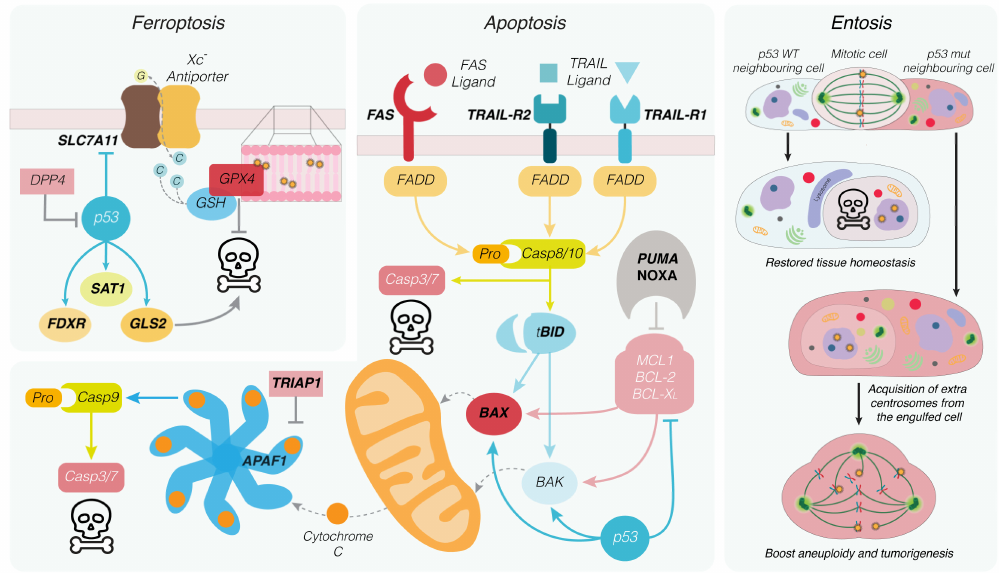
Figure 3. Critical p53-regulated cell death modalities. Upon alterations of the cellular redox state, iron-dependent peroxida- tion of membrane phospholipids can occur, promoting ferroptosis. Peroxidation can be reversed by the selenocysteine- containing protein glutathione peroxidase 4 (GPX4) in a glutathione (GSH)-dependent manner. By inhibiting the transcrip- tion of the system Xc - complex subunit SLC7A11, p53 reduces the reservoir of cysteine (C) necessary for GSH synthesis, thus preventing reversion of lipid peroxidation. Moreover, p53 controls the transcription of FDXR, SAT1 and GLS2, favouring cell death via ferroptosis. Extrinsic apoptosis is initiated by e.g. FAS or TRAIL ligand binding to their cognate receptors promoting the multimerization of receptor trimers. These form the cell death inducing signalling complex (DISC) that recruits the adapter protein FADD, which promotes activation of the initiator caspase-8, which activates in turn executioner caspases-3 and -7, alongside the BCL2 family protein BID. Intrinsic apoptosis depends solely on the balance between the inhibitory (e.g. MCL1, BCL2, BCLX) and the apoptosis-promoting members of the BCL2 family. Regardless of the apoptotic route, BAX and BAK homo-oligomerization in the mitochondrial outer membrane results in release of cytochrome C, which complexes to APAF1 forming the apoptosome. This multiprotein complex allows dimerization of the initiator caspase-9, which in turn activates the cytosolic executioner caspases-3 and -7, leading to cell death. Cells experiencing defective mitosis are prone to form cell in cell (CiC) structures with neighbouring cells in a process called entosis. In a p53 wildtype context, the internalized cell is killed by lysosomal degradation, preventing the outgrowth of defective cells. On the contrary, entosis fosters tumorigenesis in p53 mutated cells by interfering with the mitotic process of the internalizing cell and promoting aneuploidy. Direct transcriptional targets of p53 are labelled in